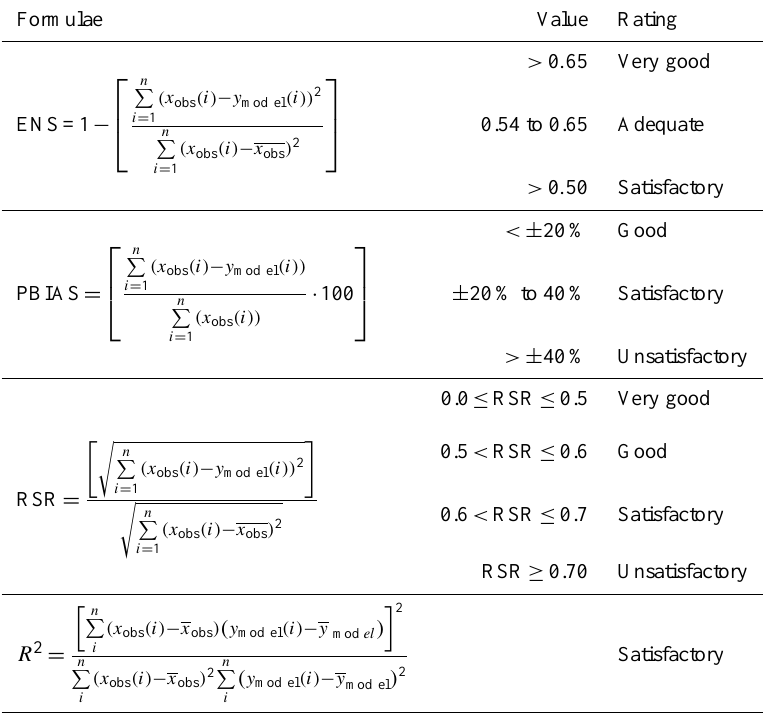
Table 5. General reported ratings for Nash-Sutcliffe efficiency (ENS) , Mean relative bias (PBIAS), Root mean square error-standard deviation ratio (RSR) and Coefficient of determination ( R 2 ) for calibration and validation process (adopted from Rossi et al., 2008). Formulae Value Rating > 0 . 65 Very